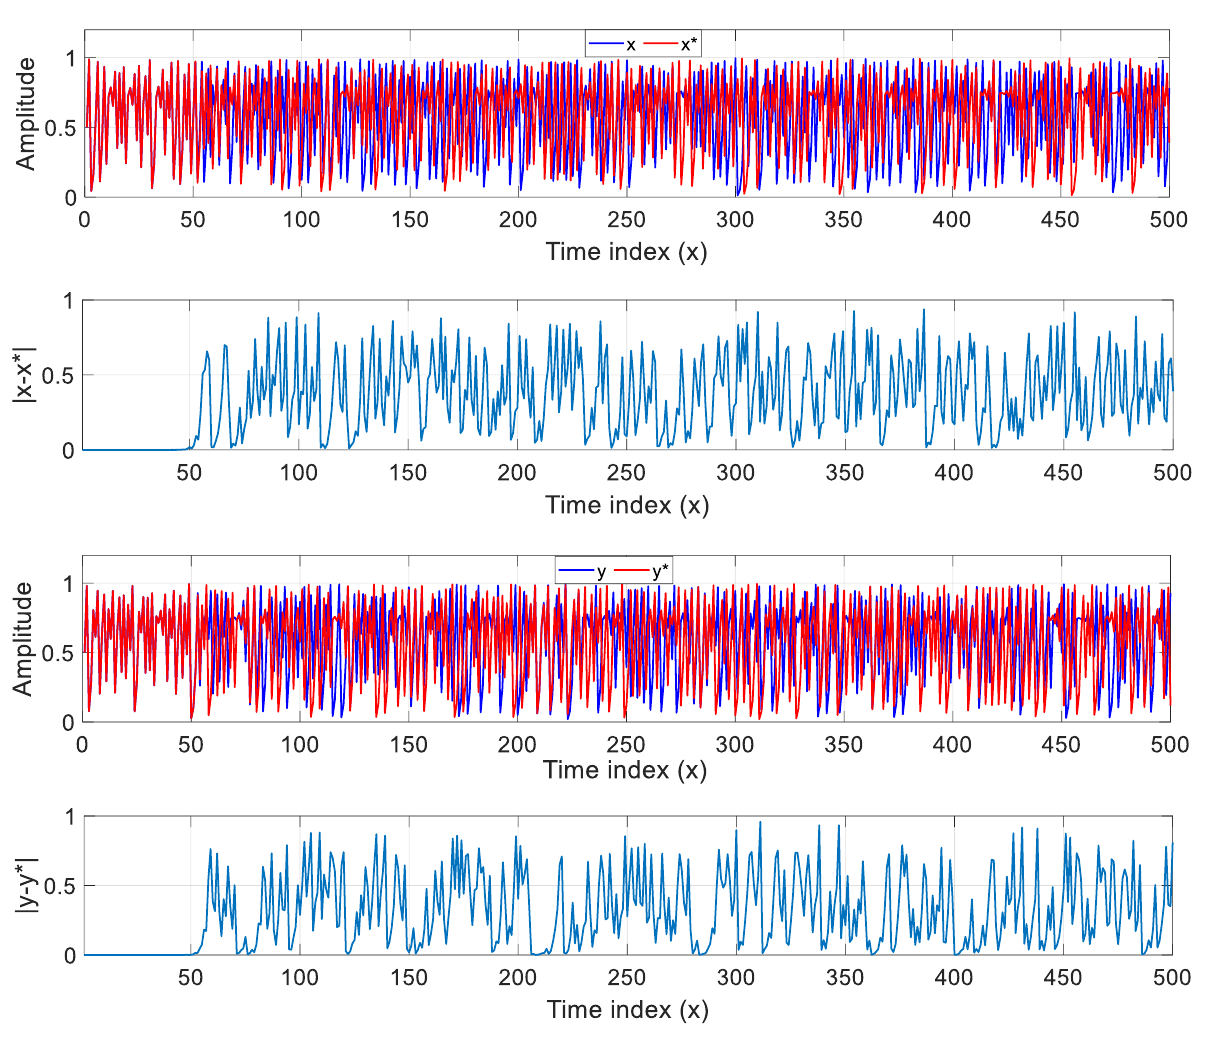
Figure 3. The first 500 iterations of x , x* , y , and y* sequences that are obtained using the parameters Figure  ,,,,, 0000